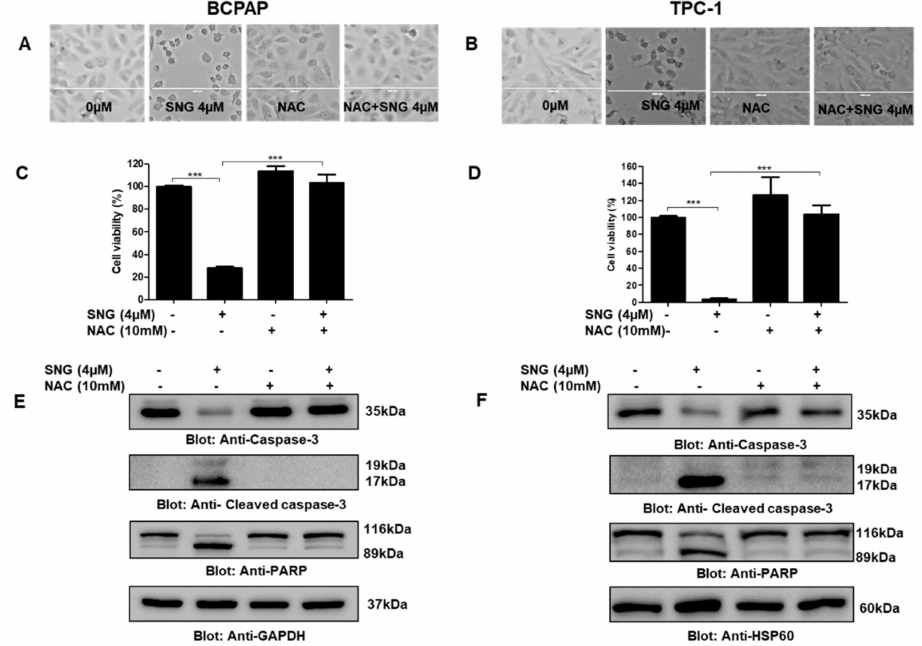
Figure4. SNG-mediatedcytotoxicactioninvolvesthegenerationofROSinPTCcells. NACpretreatment of PTC cells prevents SNG-induced morphological changes. BCPAP ( A ) and TPC-1 ( B ) cells were pretreated with 10 mM NAC for one hour and then treated with 4 µ M SNG as indicated for 4 h, and morphological changes observed using the EVOS FLc cell imaging system (Thermo Fisher Scientific). NAC treatment reversed SNG-induced inhibition of cell viability. BCPAP ( C ) and TPC-1 ( D ) cells were pretreated with 10 mM NAC followed by subsequent treatment with 4 µ M SNG for 24 h. CCK-8 was used to determine cell viability, as described in materials and methods. Values are expressed as mean +/ − SD (standard deviation) of at least six replicates with p value *** p < 0.001 ( n = 6). E ff ect of NAC treatment on SNG-induced markers of apoptosis: BCPAP ( E ) and TPC-1 ( F ) cells were pretreated with 10 mM NAC, followed by treatment with 4 µ M SNG for 4 h. Cells were lysed, and proteins were separated on SDS-PAGE, transferred to a PVDF membrane, and immunoblotted with antibodies against caspase-3, cleaved caspase-3, PARP and